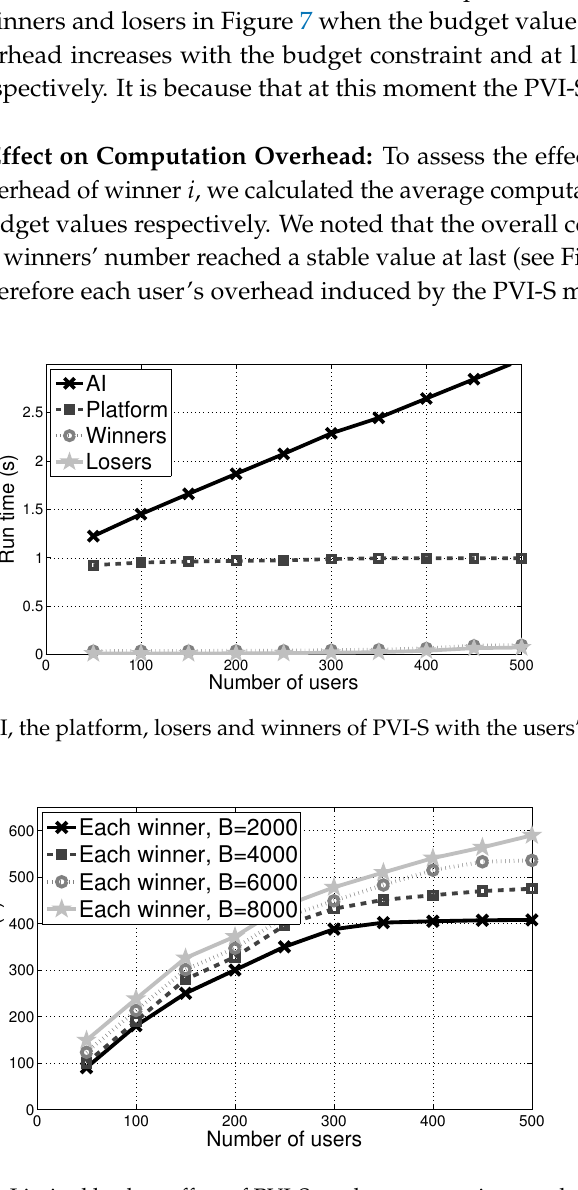
Figure 8. Limited budget effect of PVI-S on the computation